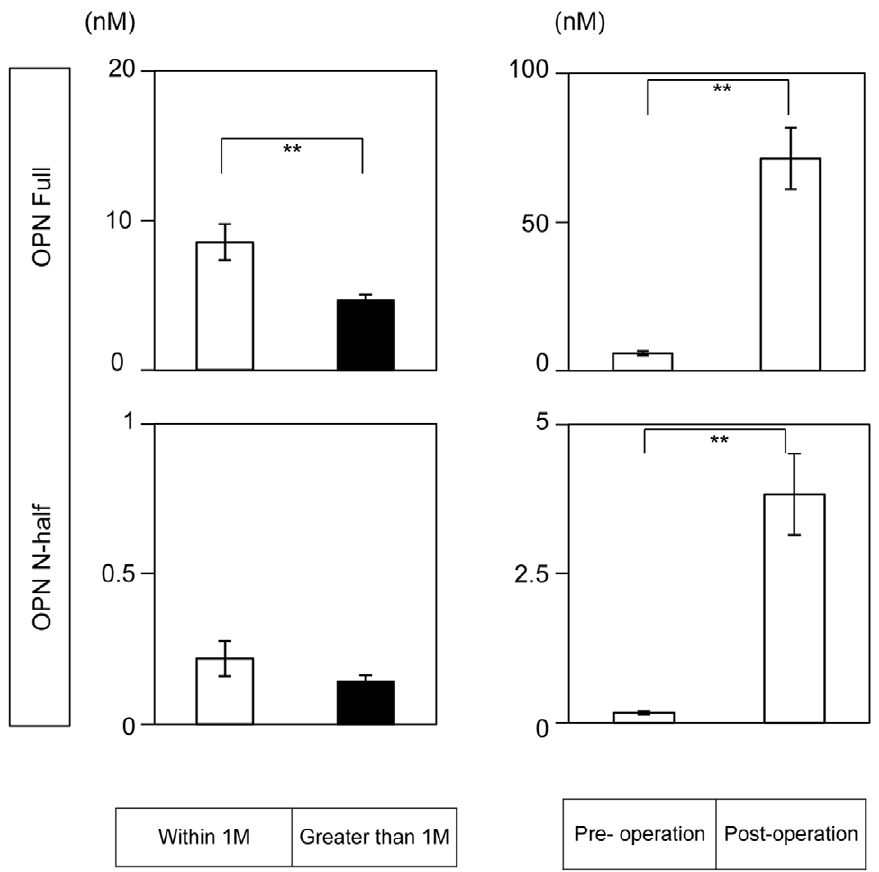
Figure 1. Kinetics of OPN Full and N-half in synovial fluid after joint injury. (Left panels) Time course changes of OPN Full (upper panel) and OPN N-half (lower panel) protein levels in synovial fluid after ACL rupture. Open bar: within 1 month after rupture n=14, Closed bar: greater than 1 month after rupture n=68. (Right panels) OPN Full (upper panel) and OPN N-half (lower panel) protein levels in synovial fluid collected from pre (n=23) and post (n=93) ACL reconstruction surgery. Data are indicated mean + / 2 SEM. **; p , 0.01.